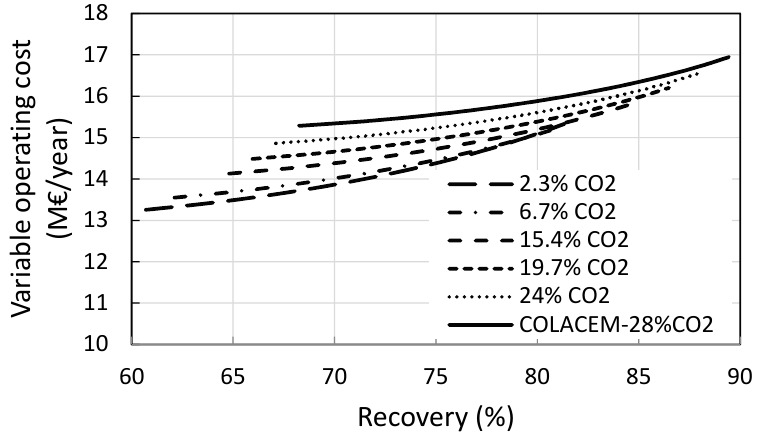
Figure 8. Effect of CO 2 molar fraction at the inlet of the membrane module on the variable operating costs at fixed sweep flow rate.